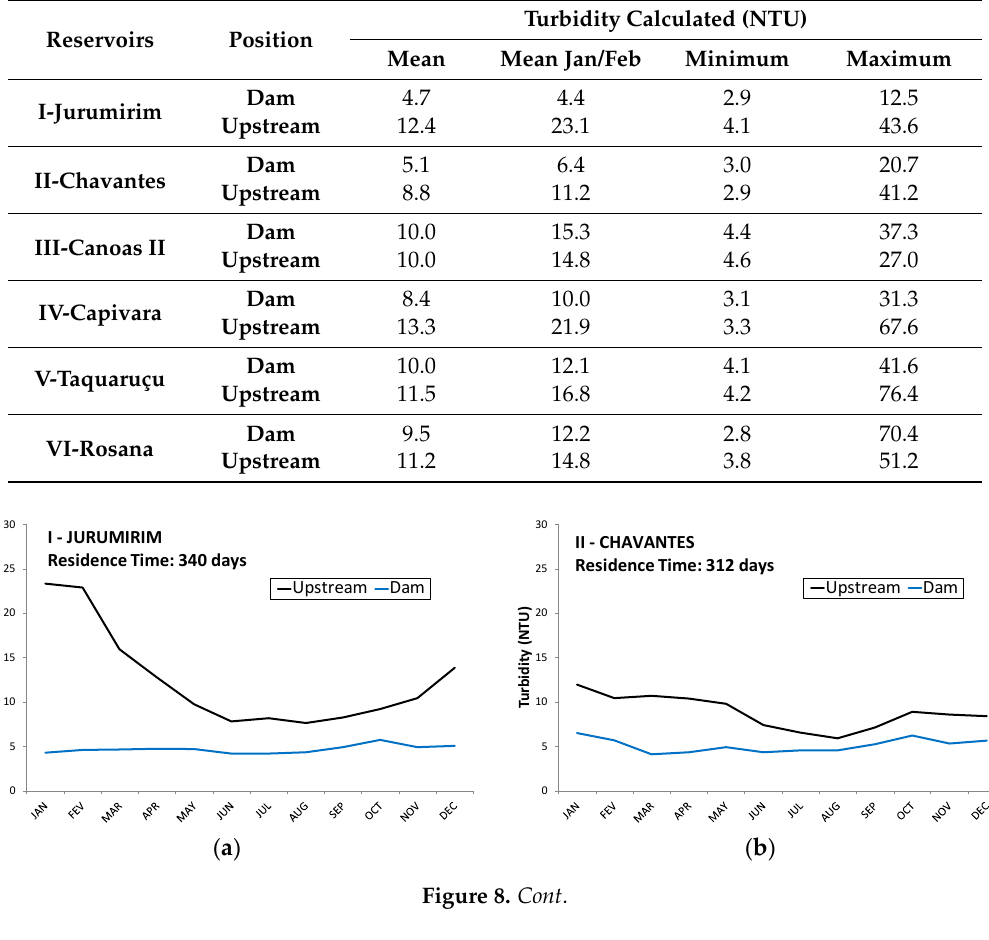
Figure 7. Monthly longitudinal variation of remote sensing-based turbidity in reservoir #1 (mean values for 2000–2013).